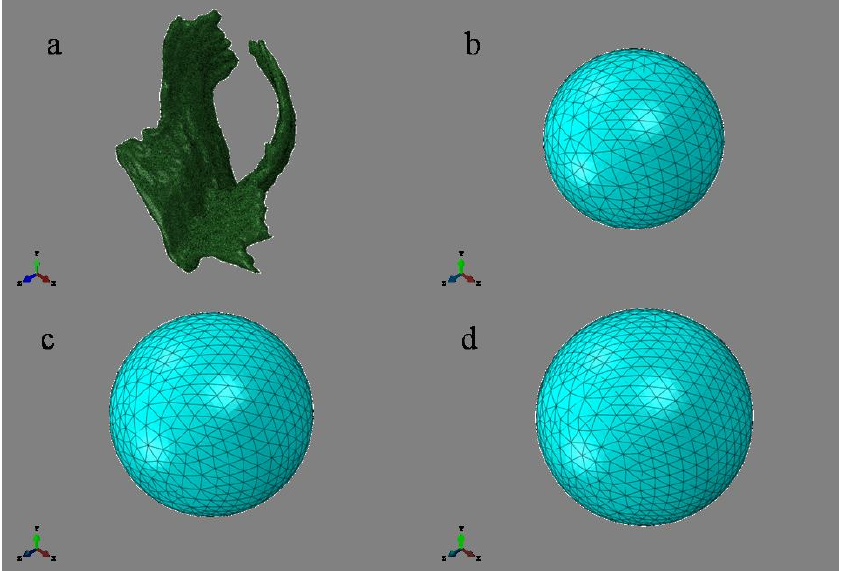
Figure 4. The part diagram with element division (( a ) Pelvic floor muscle, 114216 nodes, 515633 elements; ( b ) 80 mm, 10367 nodes, 6901 elements; ( c ) 90 mm, 15822 nodes, 10702 elements; ( d ) 100 mm, 19703 nodes, 13359 elements).